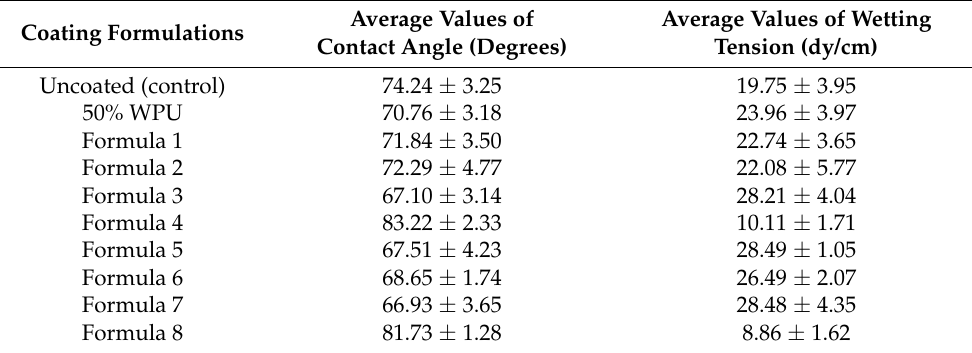
Table 3. Average values of contact angle (degrees) and wetting tension (dy/cm) of coating agents by FTA 100 Drop Shape Instrument B Frame System.